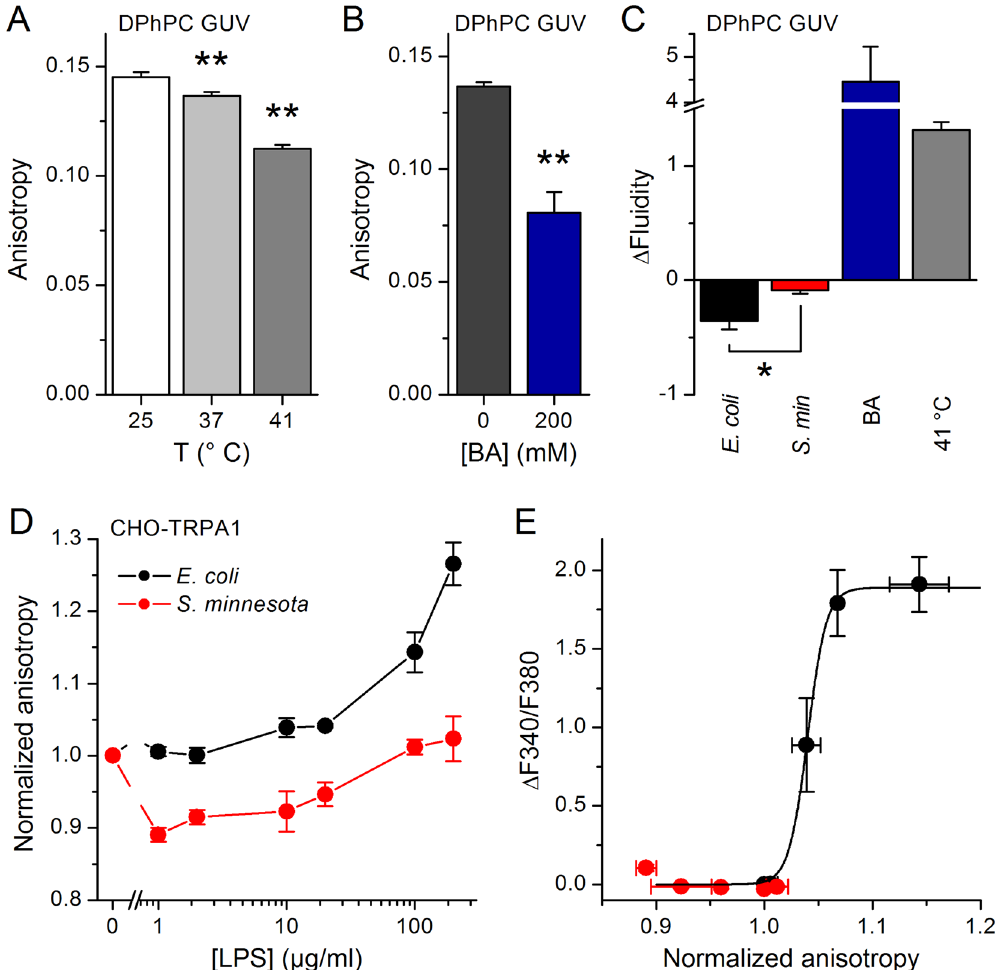
Figure 6. Differential effects of E . coli and S . minnesota LPS on the anisotropy of DPH fluorescence. ( A ) DPH fluorescence anisotropy determined at 25, 37 or 41 °C in DPhPC GUVs. ( B ) DPH fluorescence anisotropy obtained at 37 °C in DPhPC GUVs in control and in the presence of 200 mM BA. ( C ) Average change in membrane fluidity induced by E . coli LPS, S . minnesota LPS, 200 mM BA or heating to 41 °C. ( D ) Normalized anisotropy of DPH fluorescence determined at 37 °C in CHO-mTRPA1 cells treated with E . coli or S . minnesota LPS at different concentrations. The data is shown as mean ± s.e.m. from at least three experiments performed in triplicate. * P < 0.05; ** P < 0.01, Mann-Whitney U test. ( E ) Relation between LPS-induced increased intracellular Ca 2 + levels caused by TRPA1 activation and change in DPH fluorescence anisotropy recorded in CHO-TRPA1 cells upon application of E . coli or S . minnesota LPS (0–100 µ g/ml). The black line represents the fit of the data for E . coli with a Boltzmann function of the form Δ F340/F380 = Δ F340/F380 Max /(1 + exp((r − r 0 )/ s r )), where Δ F340/F380 Max is the maximal Fura2 ratio, r is the normalized anisotropy, r o is the value of normalized anisotropy for which the Fura2 ratio is half-maximal and s r is the slope